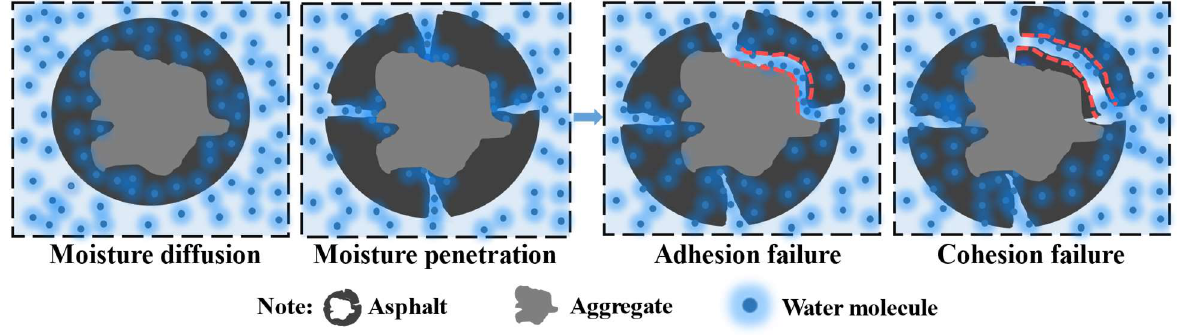
Figure 1. Moisture-induced damage process diagram of asphalt pavement. “Reprinted with permission from Ref. [4]”.